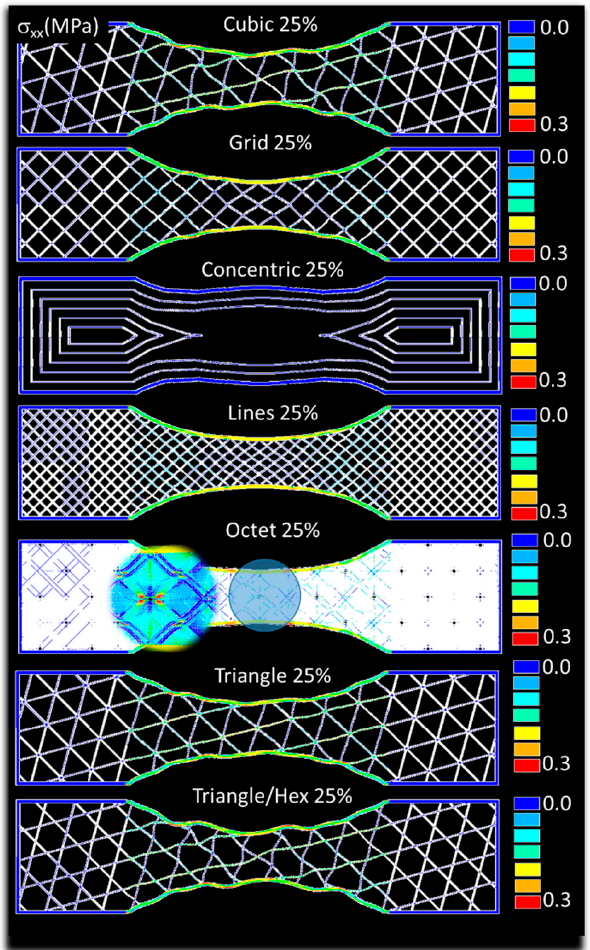
Figure 7. Predicted stress component σ xx field for varieties of airy filling patterns (infill ratio 25%).